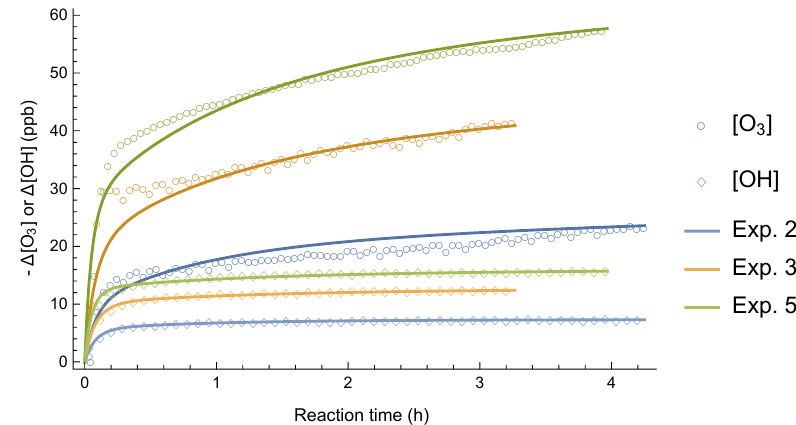
Figure 8. Plot of consumption of ozone and OH production against reaction time for experiments 2 (blue), 3 (yellow) and 5 (green). Experimental data are represented by open circles for O 3 and open diamonds for OH, whilst solid lines are modelled results using parameters listed in Table